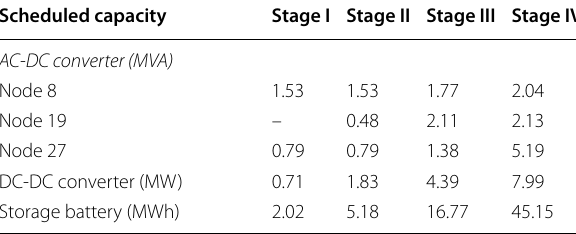
Table 3 Planning capacity of ESOP in Case